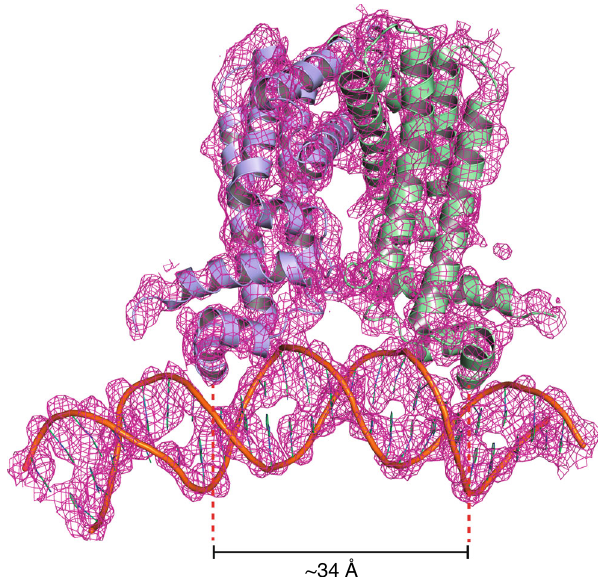
Fig. 5 Crystal structure of full-length FasR in complex with DNA. Electron density map (sigmaA-weighted 2mF obs -DF calc Fourier) is shown (magenta mesh), overlaid on the fi nal re fi ned model, showing the protein dimer (protomers in light blue and pale green) and the DNA double helix (orange) in cartoon representation. The map was carved around the atomic model with a border of 3 Å to improve the clarity. Helices α 3 are seen fi tting within the DNA major groove as